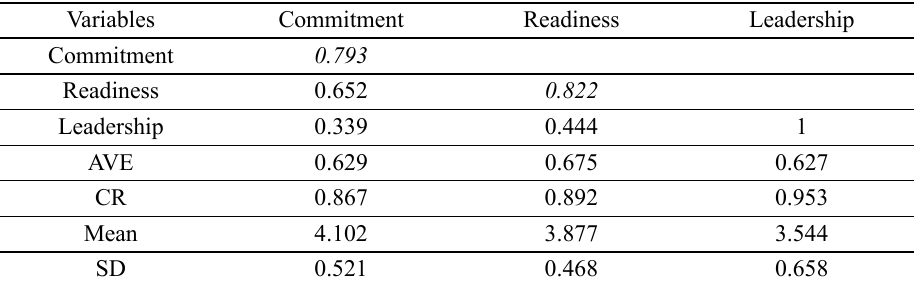
Table 3. Convergent and discriminant validity (N =